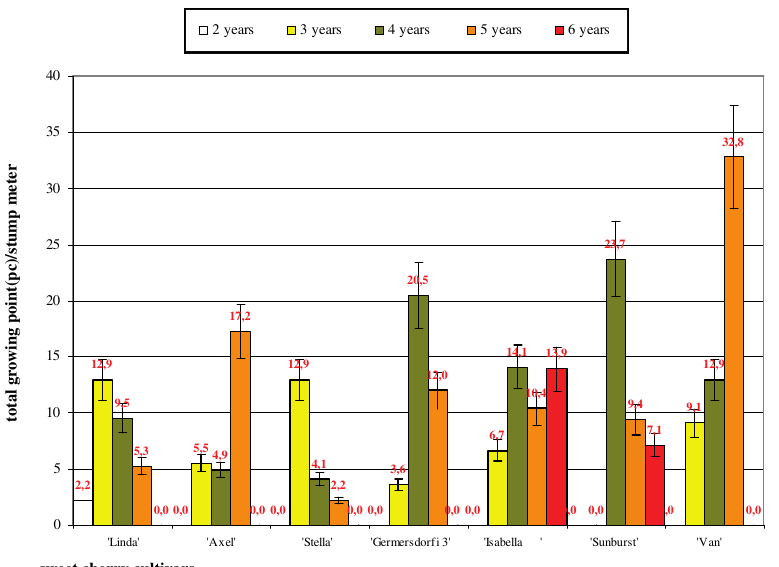
Figure 1: Intensity of regeneration on stumps of different age expressed by the number of growing points in sweet cherry varieties (Debrecen-Pallag, 2009)